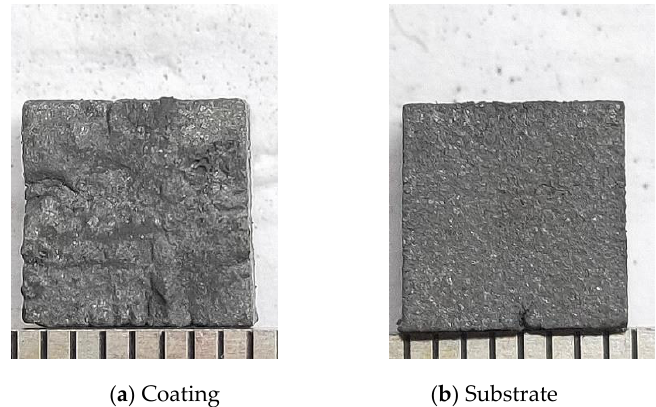
Figure 12. Macroscopic photos of different samples after first crack thermal shock; ( a ) Coating; ( b ) Substrate.